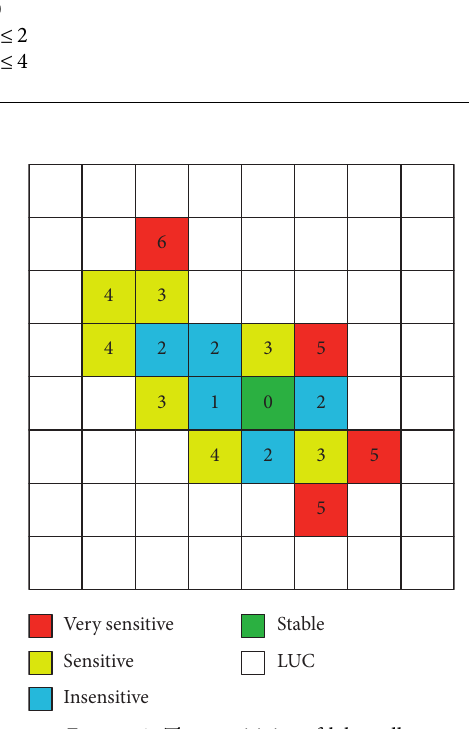
Figure 9: The sensitivity of lake